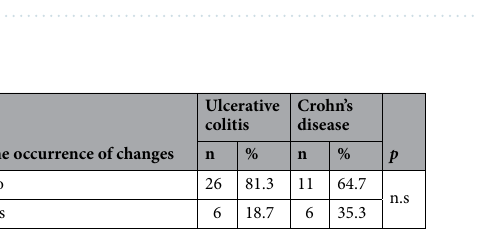
Table 3. Nonspecific manifestations of IBD in the oral mucosa in the study and control groups.